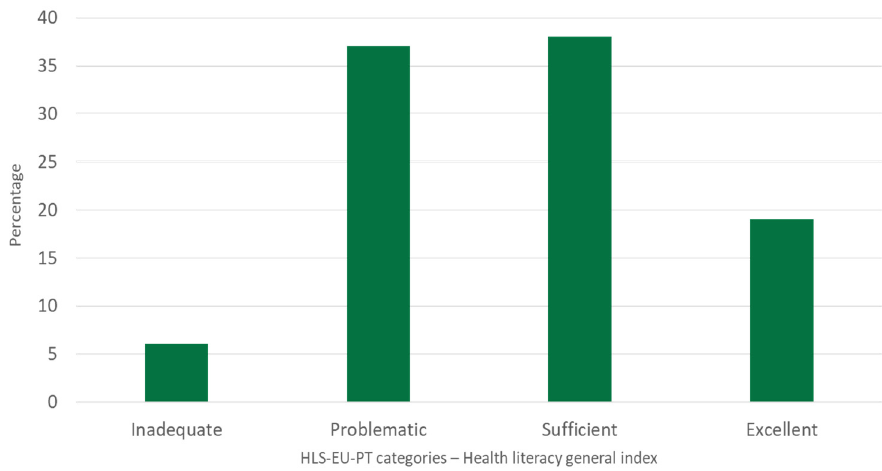
Figure 1. Caregivers’ Health Literacy distribution—Health literacy general index (HLS-EU-PT).